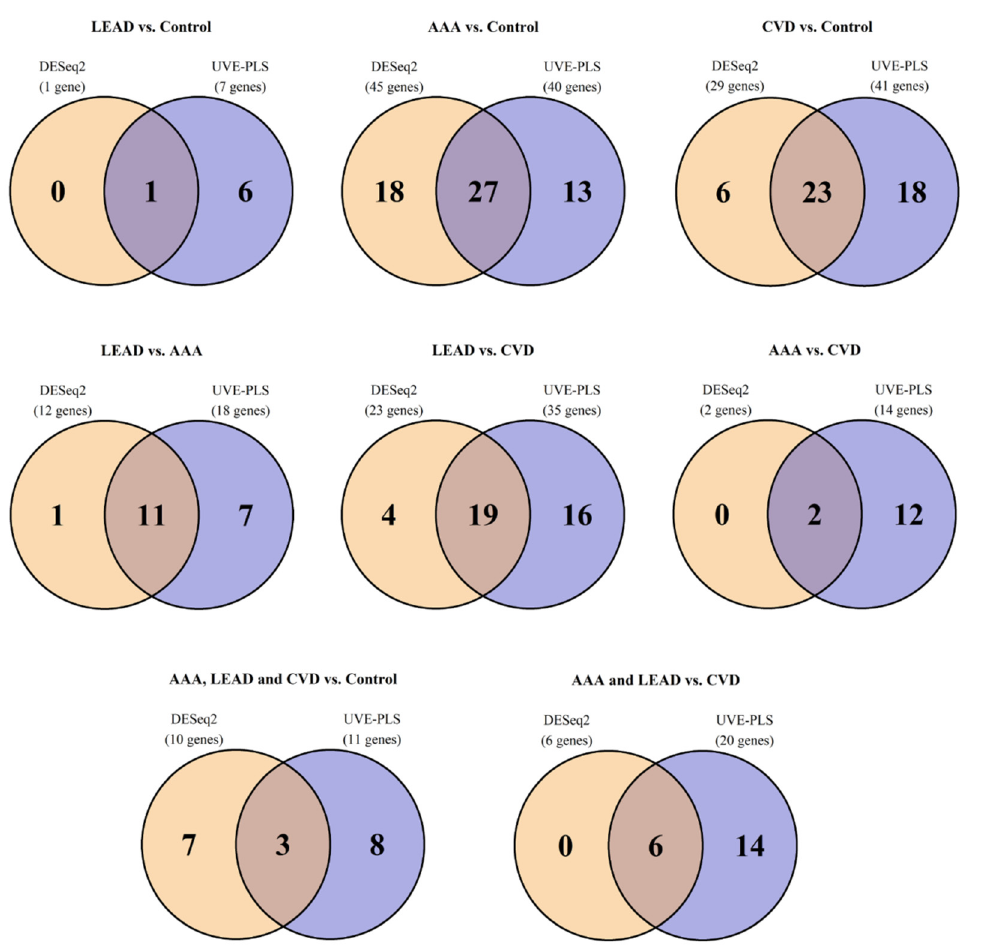
Figure 2. Relations of the quantity of differentially expressed genes in the pairwise and pooled group comparisons. Gene sets were obtained by DESeq2 and UVE–PLS methods with unified selection criteria applied ( p value adjusted by Benjamini—Hochberg false discovery rate < 0.05 and fold change > 1.2 (for upregulated genes) or <0.8 (for downregulated genes), as well as UVE-PLS reliability score ≥ 5). The numbers in overlapping fields in each Venn diagram represent the number of genes shared by both DESeq2 and UVE-PLS gene sets.